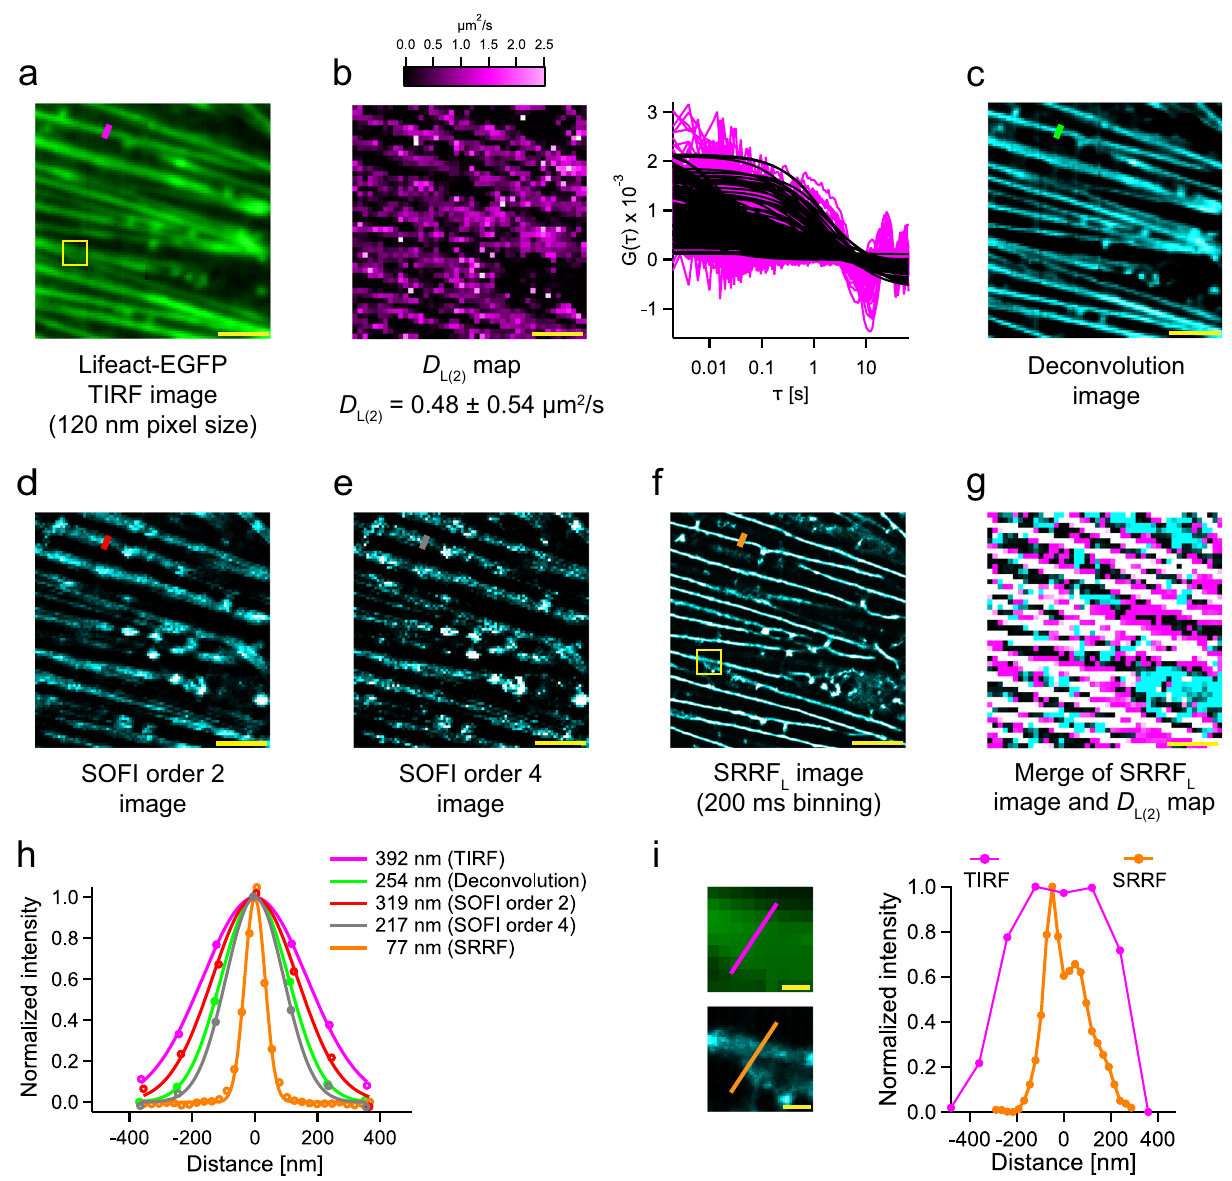
Fig. 2 Multi-parametric analysis from a single channel fl uorescence data set. a TIRF image of CHO-K1 cell expressing Lifeact-EGFP at ×200 magni fi cation (120 nm pixel size). b The D map without thresholding ( D L(2) = 0.48 ± 0.54 µ m 2 /s) is shown on the left. The COV is 113%. Representative ACFs are shown on the right. c – e Deconvolution image, SOFI image of order 2, SOFI image of order 4, respectively. f SRRF L image (200 ms binning; refer Supplementary Fig. 4) of the cell in ( a ). g Merge of the SRRF L image and D L(2) map. The SRRF L , D L(2) and correlated pixels are coloured cyan, magenta and white, respectively. White pixels identify where the SRRF L image and the diffraction-limited D L(2) map coincide. Cyan pixels show fi bres in SRRF L but no correlated D is found (SRRF artefacts). Magenta pixels show a D consistent with diffusion on fi bres but no structure in SRRF. Due to the effect of the diffraction limit of Imaging FCS, not all pixels consistent with diffusion on fi bres are observed in the SRRF L image. h Thickness (FWHM of the Gaussian fi t) of the actin fi bre in TIRF image (magenta line in ( a )) = 392 nm. Thickness of the actin fi bre after deconvolution (green line in (c)) = 254 nm. The thickness of the actin fi bre after SOFI-order 2 (red line in ( d )) = 319 nm. The thickness of the actin fi bre after SOFI-order 4 (grey line in ( e )) = 217 nm. The thickness of the actin fi bre after SRRF (orange line in ( f )) = 77 nm. Refer to Supplementary Fig. 6 for more details. i Enlarged views of yellow boxes in images ( a ) and ( f ). The intensity pro fi le shows the actin fi bre branching point (indicated by the orange line on the enlarged SRRF image). The peak-to-peak resolution is 96 nm at this point. The pixel sizes reported are after magni fi cation (refer Table 3). The scale bars shown in yellow measure 2.5 µ m in images ( a ) – ( g ), and 250 nm in ( i ). All values are reported as Mean± SD. The analyses were performed on four cells from four different preparations of a single batch of cells with similar results. One representative cell is shown here. Source data is available as a Source data fi